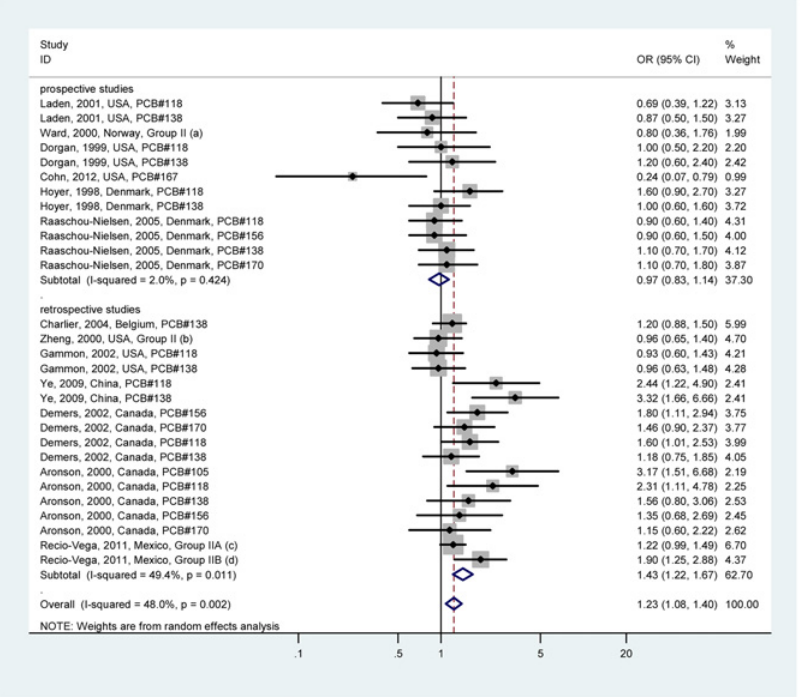
Fig 4. Forest plot describing the association between potentially antiestrogenic and immunotoxic, dioxin-like PCBs (Group II) exposure and breast cancer risk. Apart from the overall analysis, the subgroup analyses on prospective (upper panels) and retrospective (lower panels) studies are presented. (a) Group II includes PCB congeners 74, 118, 138, 156 and 170; (b) Group II includes PCB congeners 74, 118, 138, 156, and 170; (c) Group IIA includes congeners 66, 77, 105, 118 and 126; (d) Group IIB includes congeners 128, 138 and